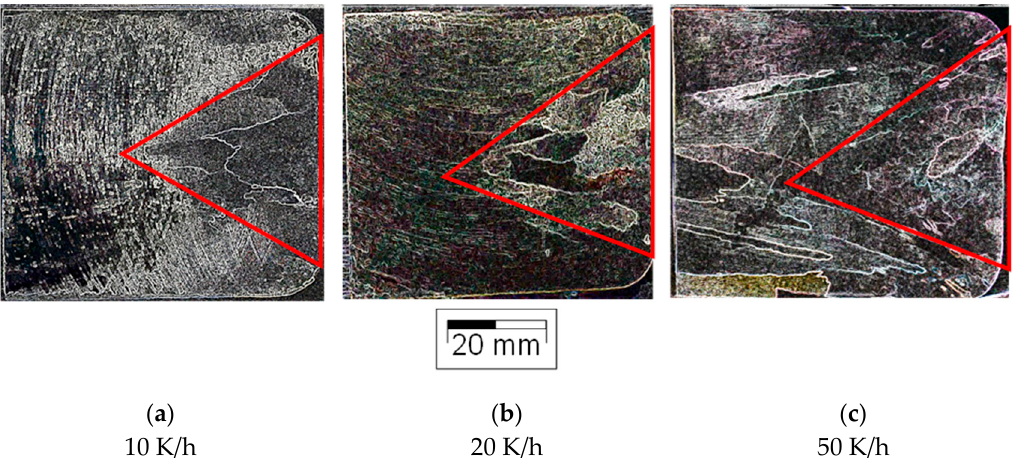
Figure 5. Grain structure of samples 1.1.A ( a ), 2.1.A ( b ), and 3.1.A ( c ) at a temperature gradient of 20 K and cooling rates of 10, 20, and 50 K/h.